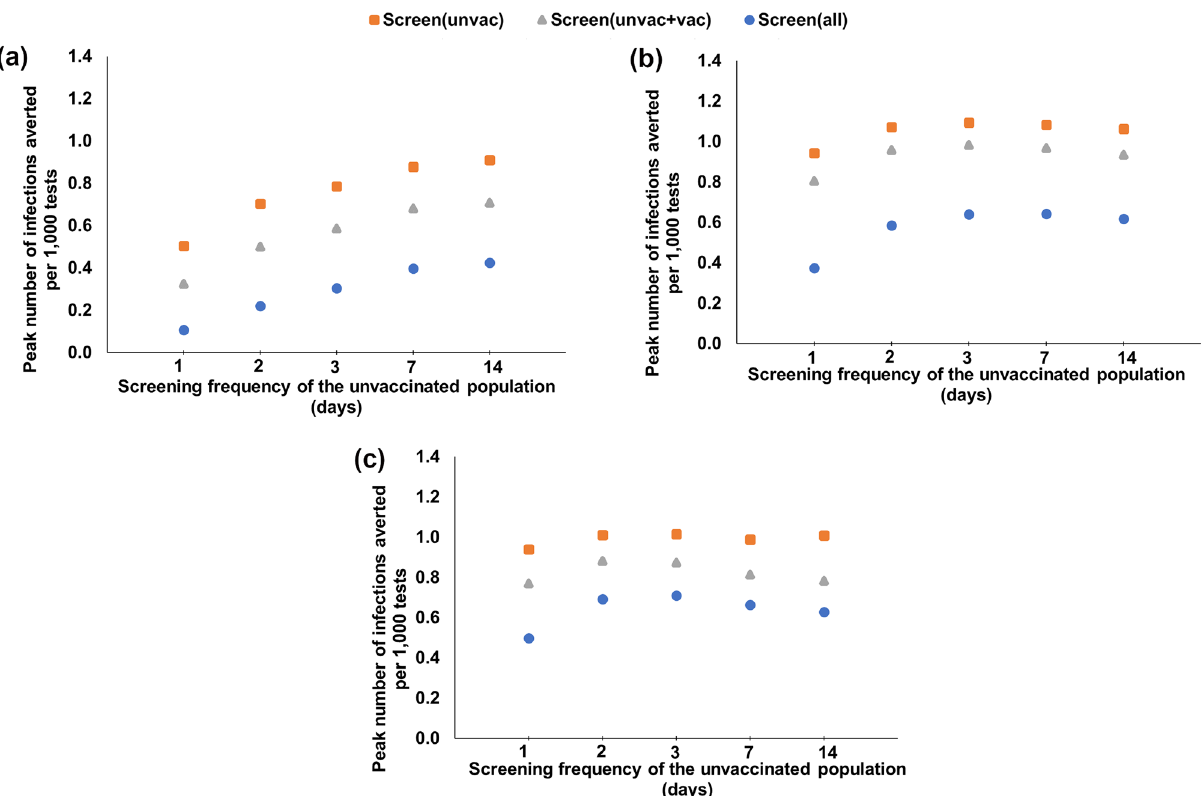
Figure 2. Peak number of infections averted per 1000 tests with respect to the screening frequency of the unvaccinated, for various universal and customized screening strategies under various booster and vaccination coverages and Omicron proportions. ( a ) ω O = 50% , 64% boosted, 18% vaccinated, 18% unvaccinated, ( b ) ω O = 95% , 64% boosted, 18% vaccinated, 18% unvaccinated and ( c ) ω O = 95% , 38% boosted, 44% vaccinated, 18%